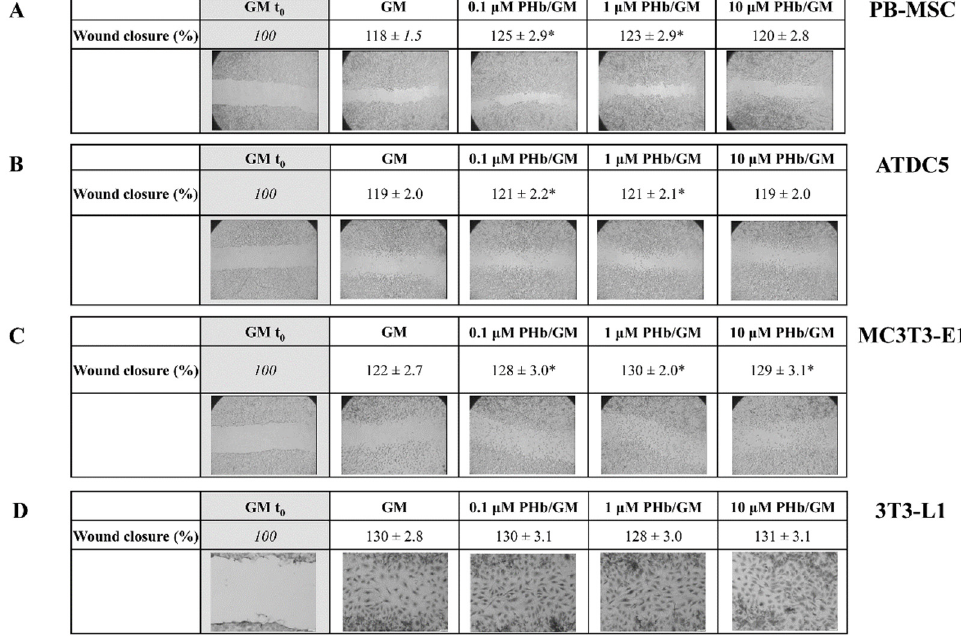
Figure 3. Acellular porcine hemoglobin (PHb) modulates migratory capacity of mesenchymal cells. Migration of PB-MSCs ( A ), ATDC5 ( B ), MC3T3-E1 ( C ), and 3T3-L1 ( D ) cells analyzed by “scratch” assay (micrographs magnification: 40×). Upon making a “scratch” in confluent cell monolayer, cells were cultured for 24 h in the presence of growth medium (GM) or GM supplemented with PHb. The surface formed immediately after making the “scratch” was labeled “GM t 0 ” and represented the control of the experiment (set as 100%). Results are percentages of the scratch areas covered with migrating cells, relative to GM t 0 . Mean ± SD of three independent is shown. * p < 0.05, compared to the corresponding control.